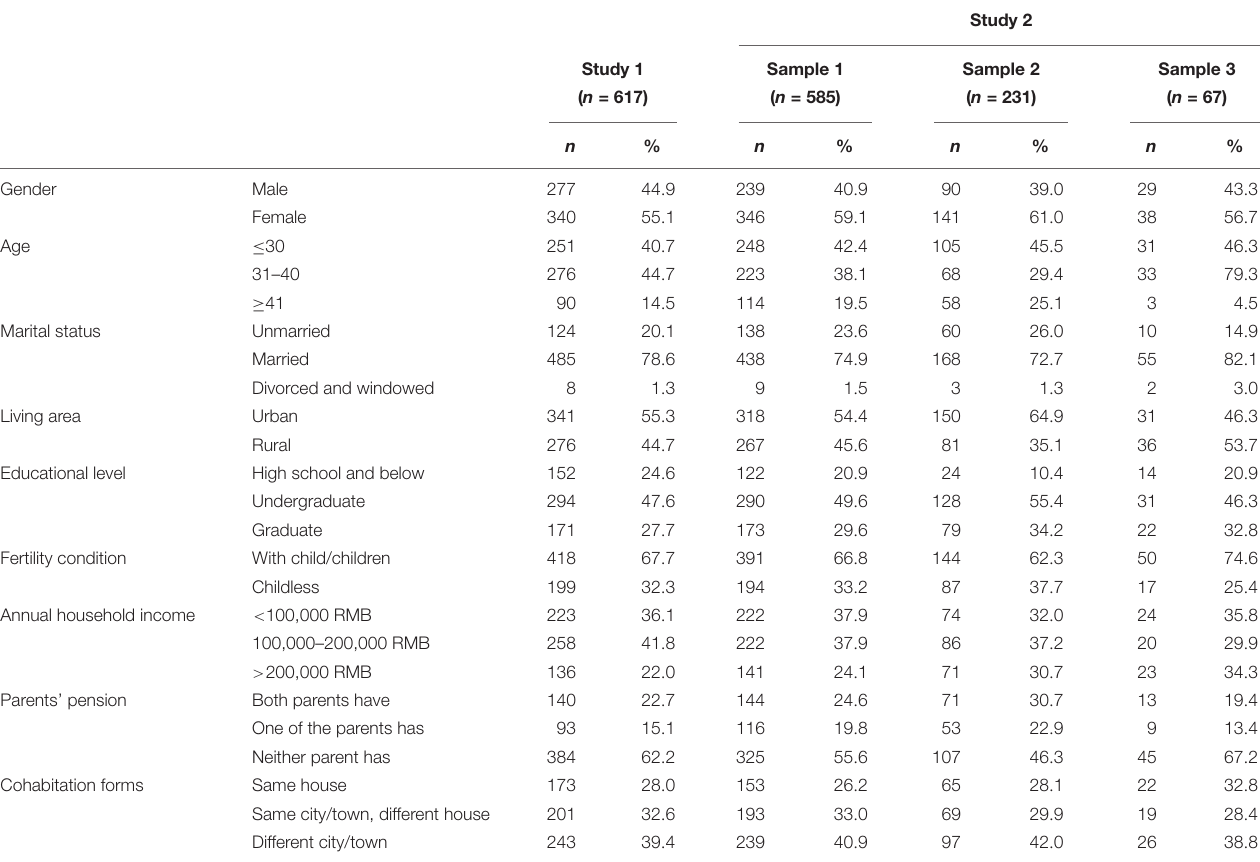
TABLE 1 | Demographic information of